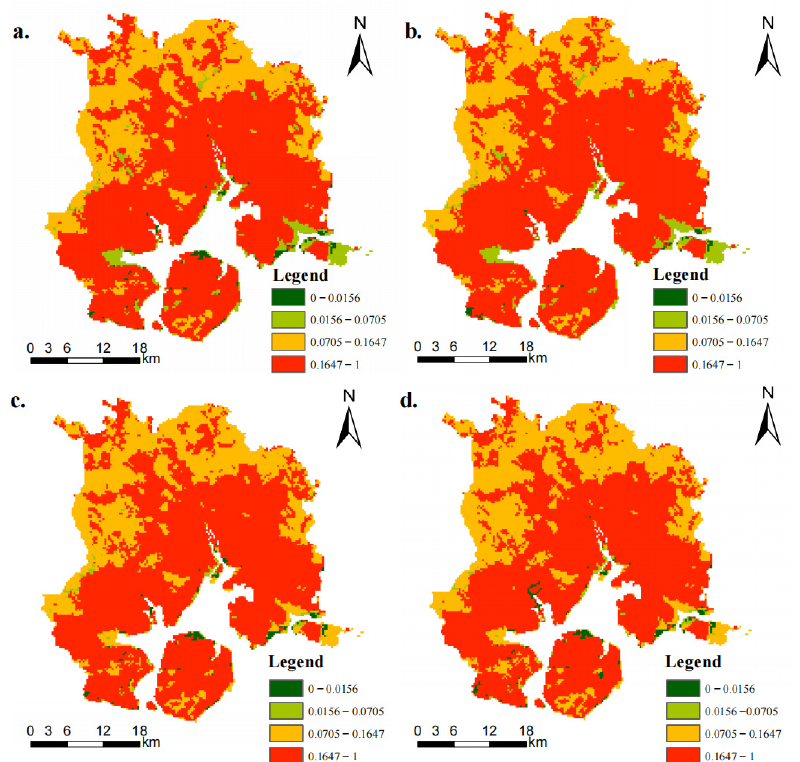
Figure 6. Land use vulnerability index distribution in 2020 and 2030: ( a ) 2020; ( b ) NDS; ( c ) PIS; and ( d ) SDS.